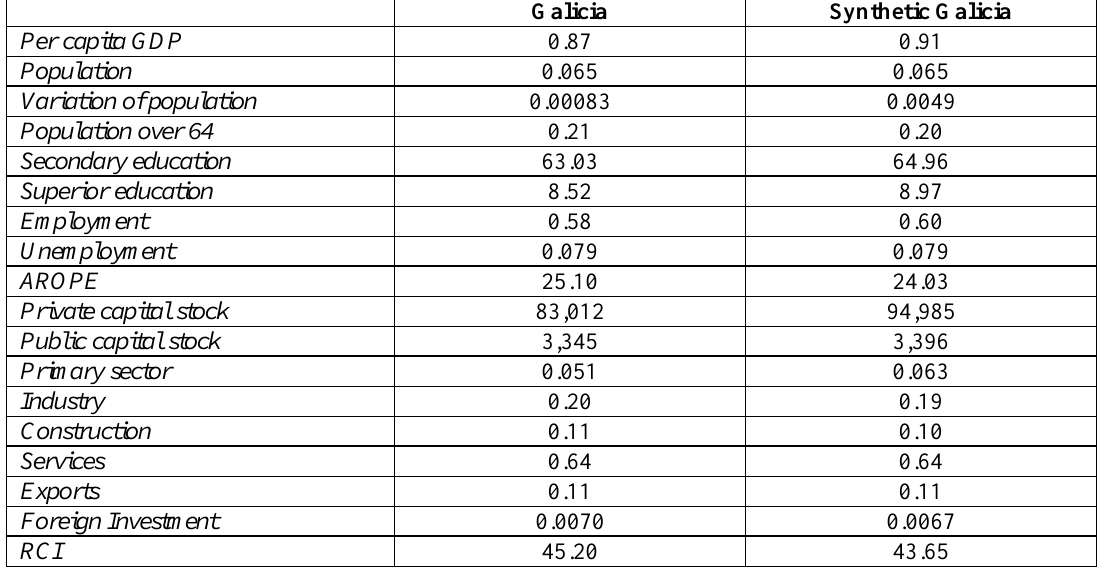
Table 6 : SCM estimation